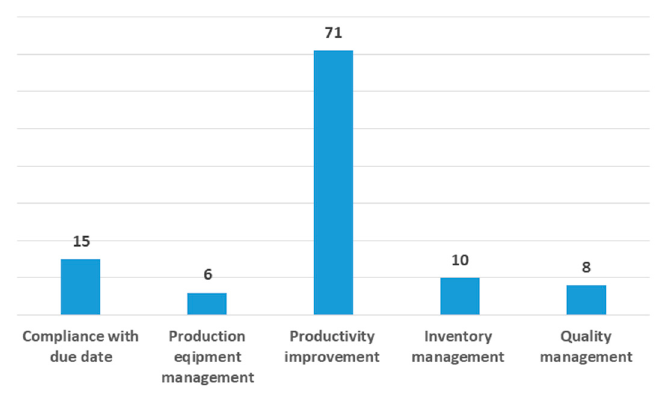
Figure 12. Purpose of promoting smart factory.